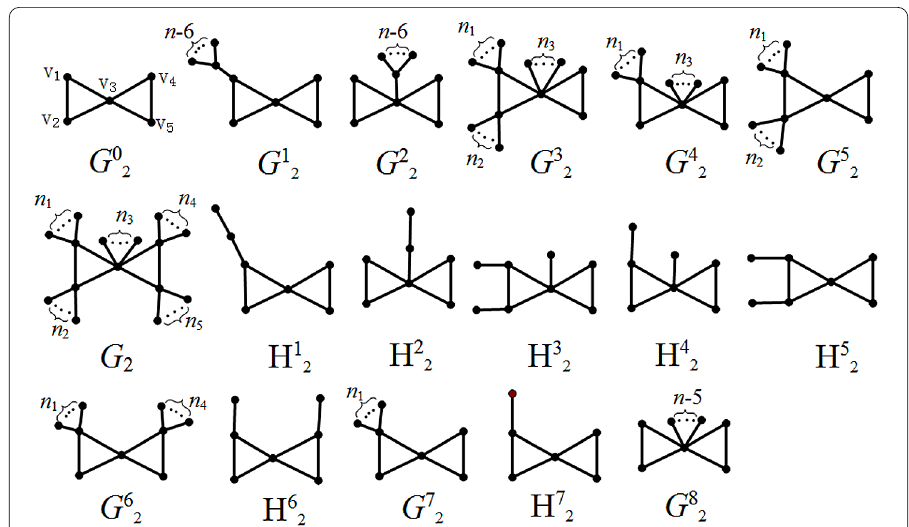
Figure 4 Some bicyclic graphs with ∞ (3,3,0) as their